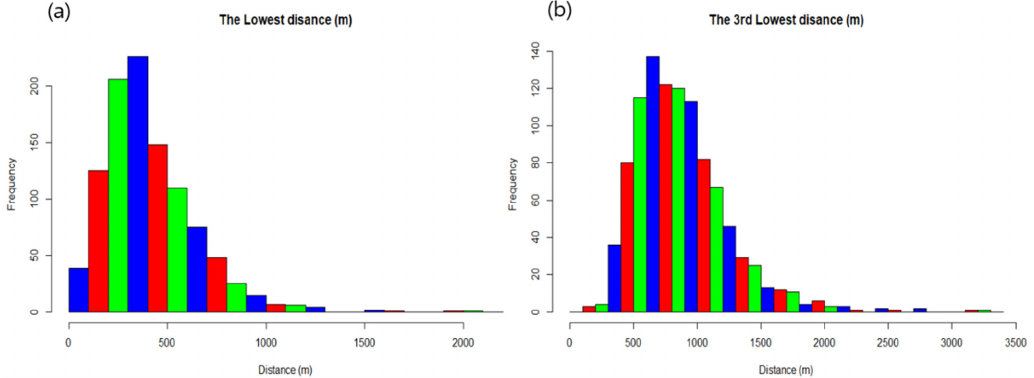
Figure 8. Histogram of ( a ) the shortest and ( b ) the third-shortest distance between two stations.